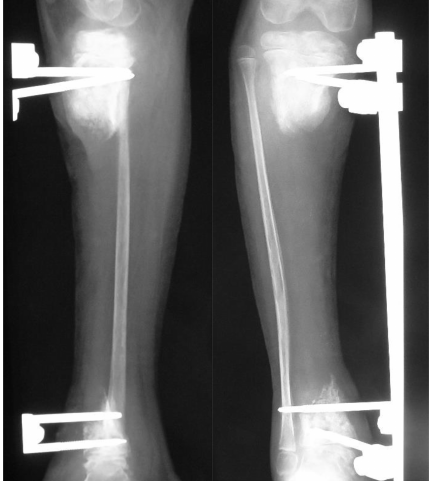
Figure 2. Radiographs showing the post-sequestrectomy bone de- fect in a 7-year-old child, who presented with exposed sequestrum, loss of soft tissue cover and septic arthritis of the ankle joint. In the presence of short residual stumps and unhealthy skin, the osteocu- taneous flap is certainly a valid option for managing both issues.